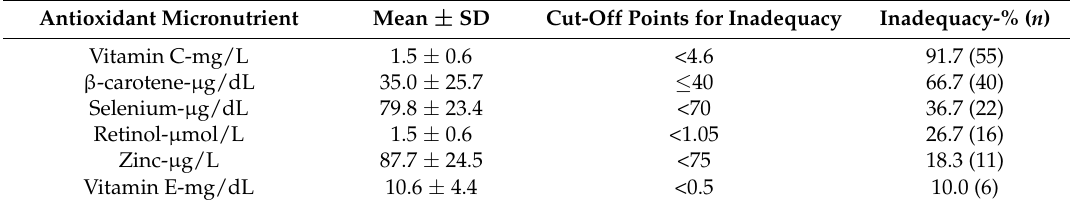
Table 2. Proportion of participants who had inadequate micronutrients status with antioxidant function in the sample of adolescents with severe